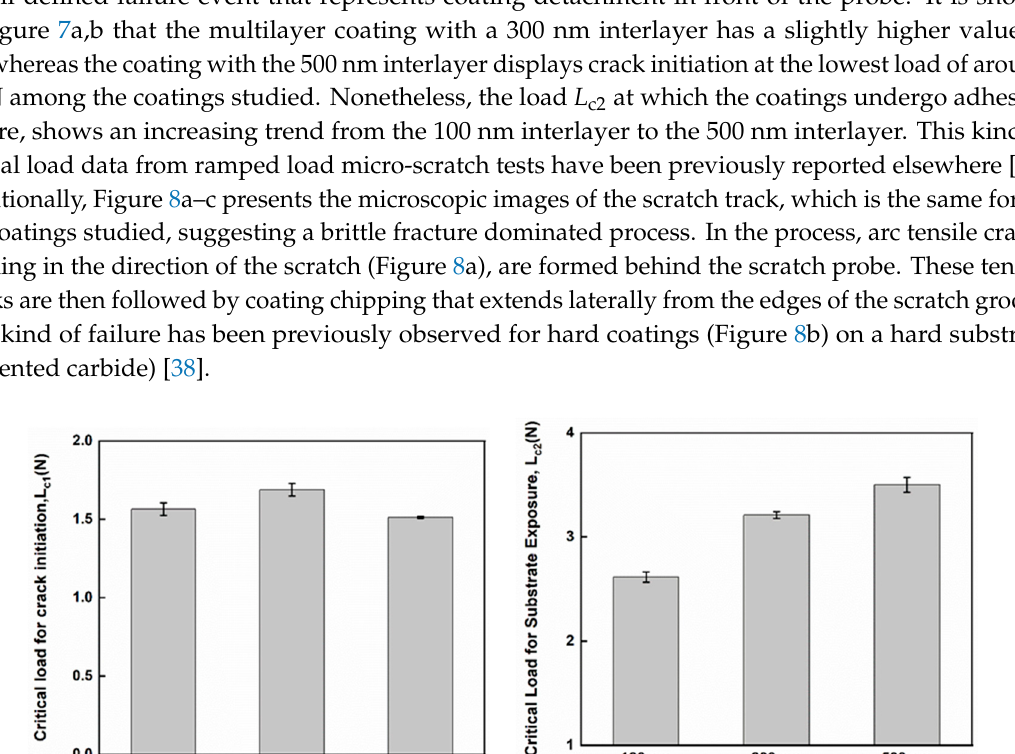
Figure 6. ( a ) Depth dependent hardness variation at a load range of 5–100 mN; ( b ) mechanical properties of the studied coatings obtained through nano-indentation tests (elasticity obtained by taking the Poisson’s ratio of all coatings to be 0.25). Table 4. Variation of dimensionless parameter H 3 / E 2 and H / E with the interlayer thickness. Coating Multilayer Multilayer